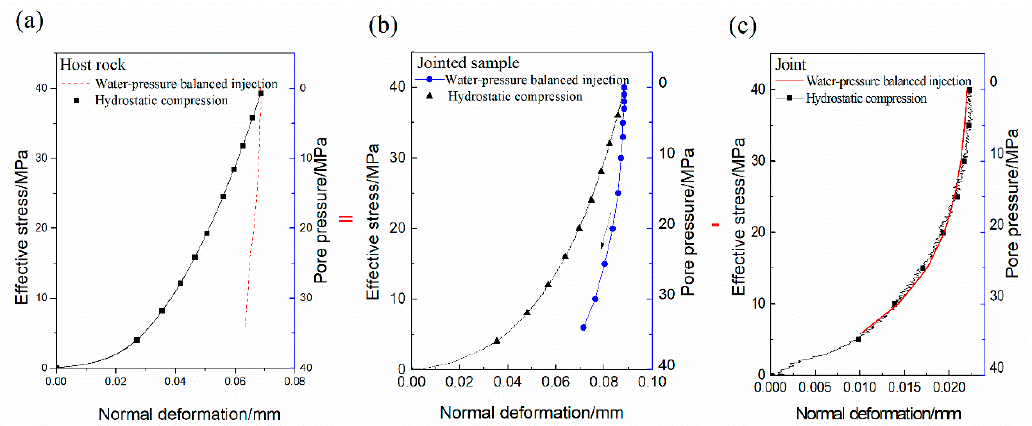
Figure 12. Decomposition of normal deformation of jointed sample induced by pore water pressure: ( a ) component of host rock; ( b ) total deformation of jointed sample; and ( c ) component of the joint.